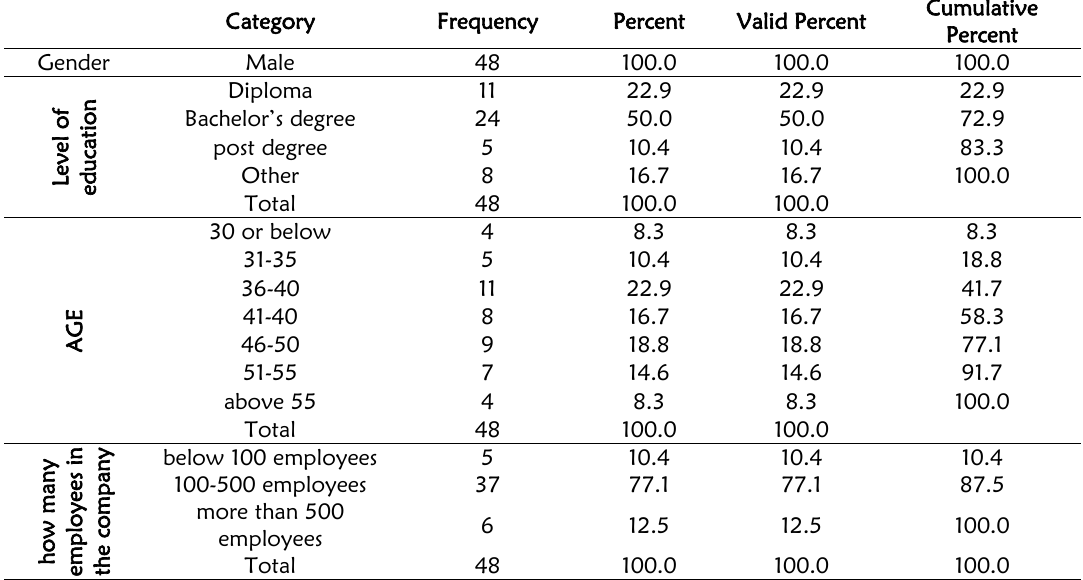
Table 1: Demographic distribution of